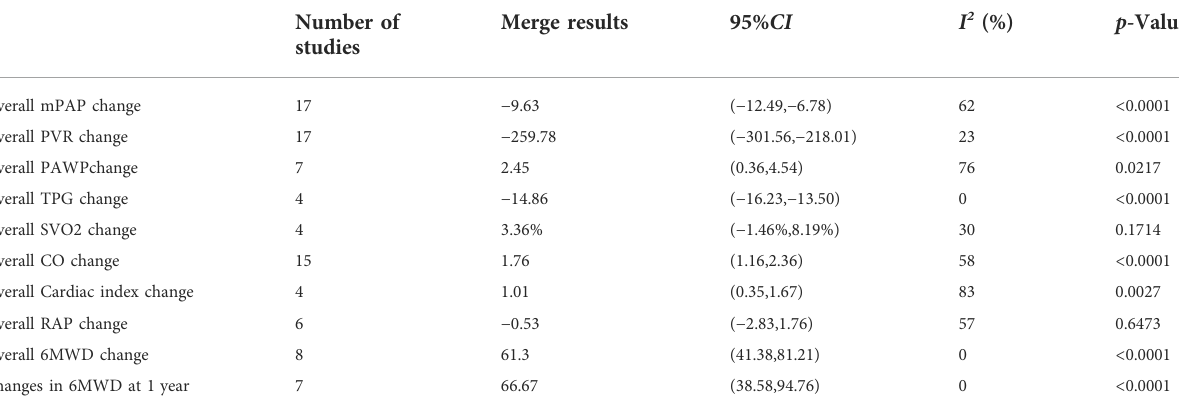
TABLE 4 Changes of hemodynamics and 6MWD in patients with moderate and severe POPH.